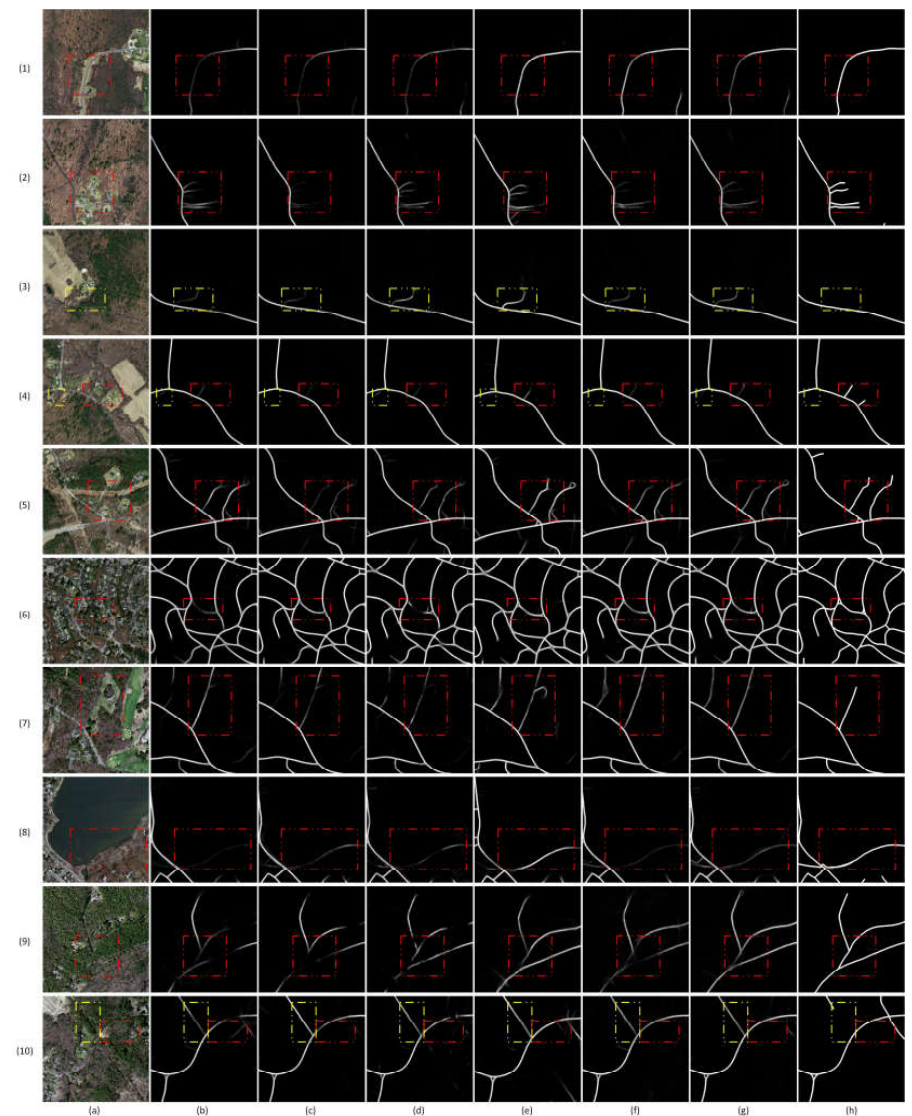
Figure 8. Comparison of road extraction results on Massachusetts road datasets: ( a ) Input Image. ( b ) Result from CasNet. ( c ) Result from U-Net. ( d ) Result from Res-U-Net. ( e ) Result from D-linkNet101. ( f ) Result from JointNet+Binary Cross-entropy (BCE). ( g ) Result from JointNet+Focal Loss (FC). ( h ) Ground